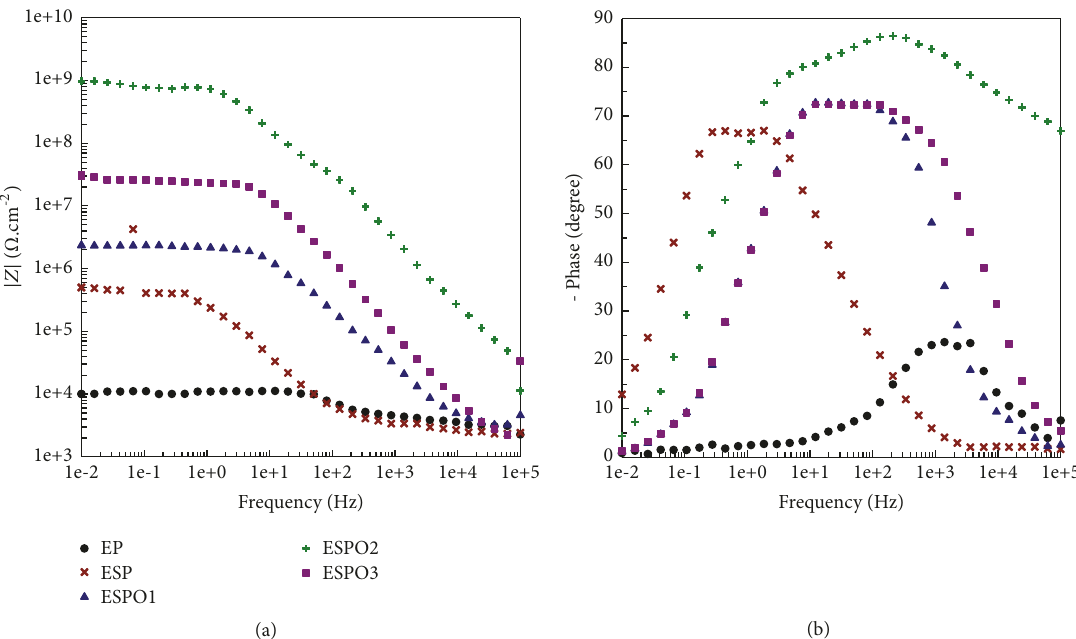
Figure 9: Bode plots of coatings after 35 days of immersion in 3% NaCl